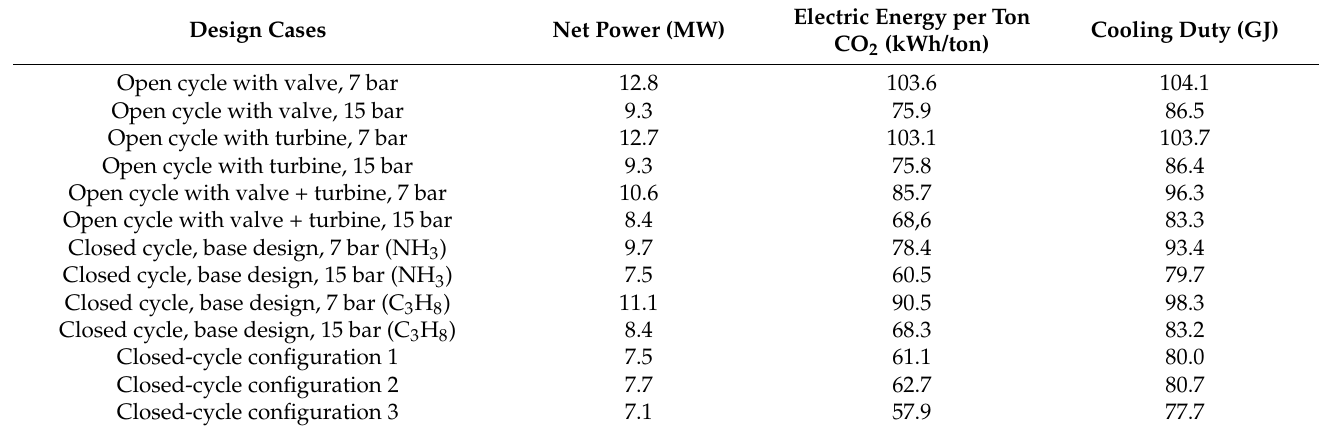
Table 10. Summary of the